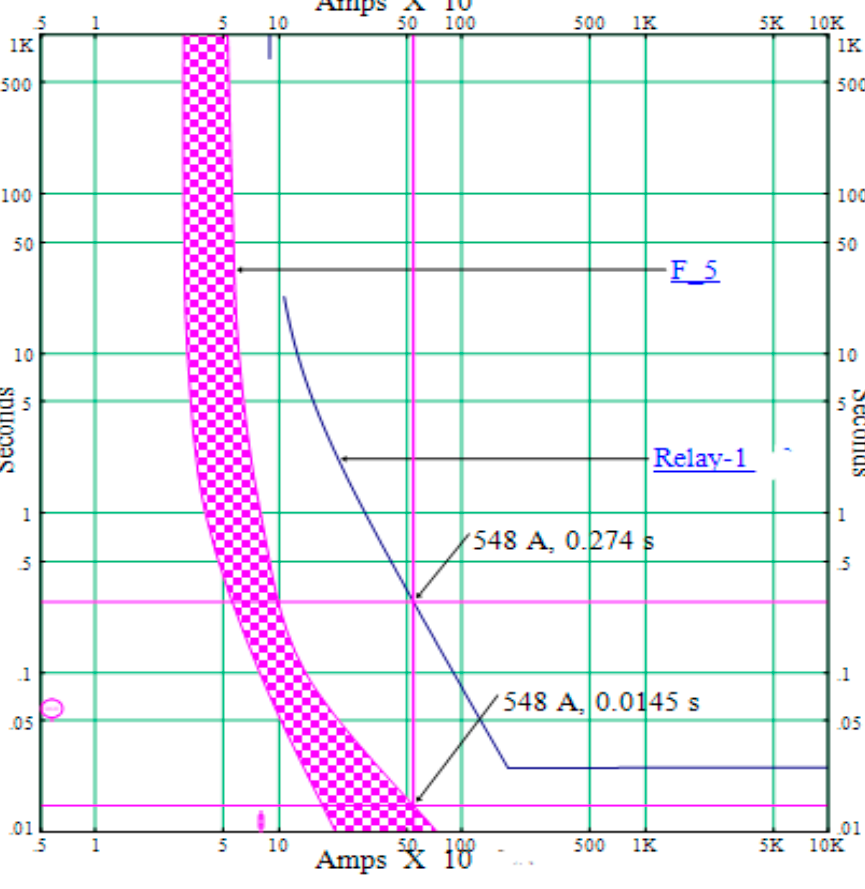
Figure 15. Log–log diagrams of the relay and downstream fuse 5.